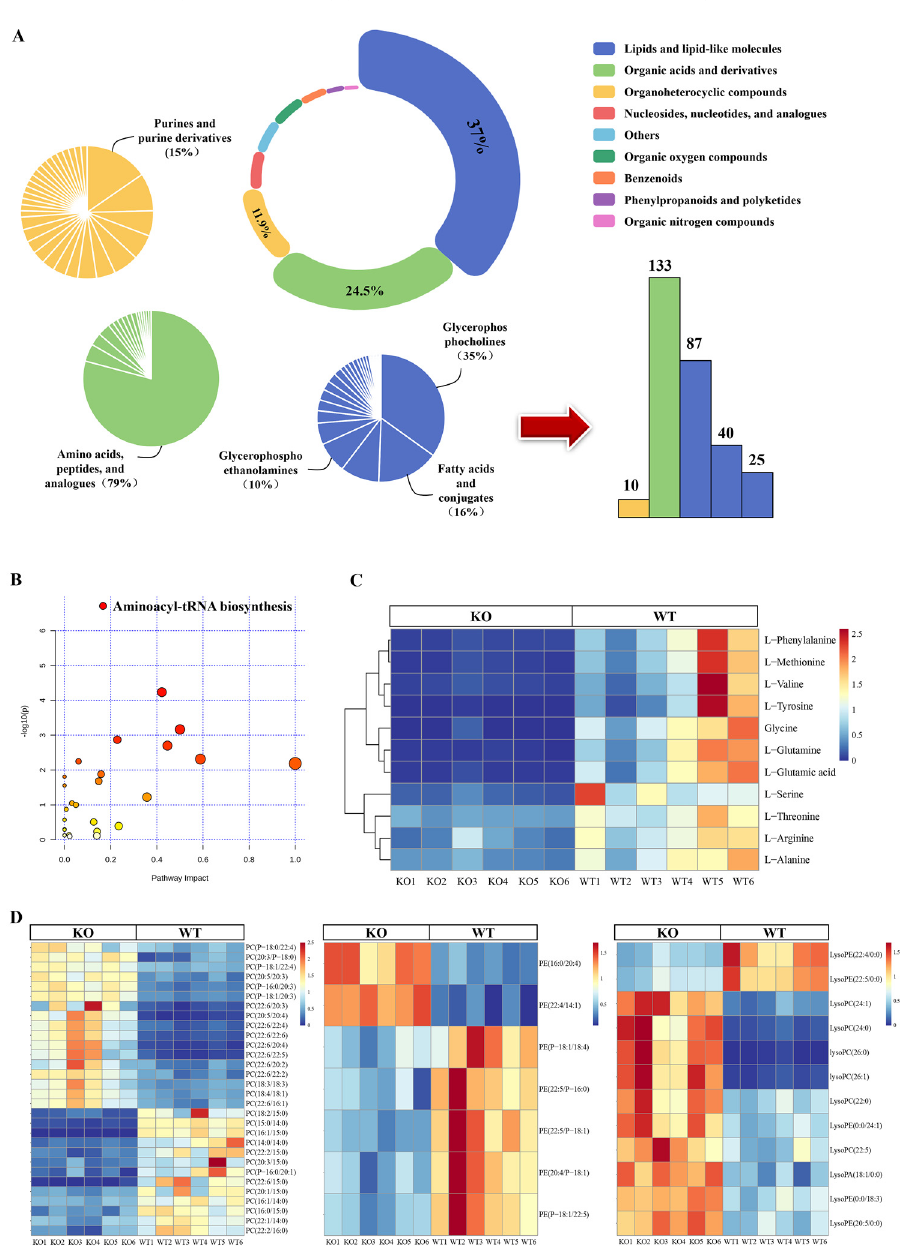
Figure 2. Identification of differential metabolites in KO cells. ( A ) Structural composition of differential metabolites. The composition and quantity distribution of the top three metabolites are displayed. ( B , C ) Functional annotation of amino acids, peptides, and analogues metabolites. Metabolite enrichment showed that aminoacyl-tRNA was the most severely affected, and all the detected metabolites were downregulated in the aminoacyl-tRNA pathway. ( D ) The altered glycerophospho- choline is mainly PE, LysoPE, LysoPC, and PC. Metabolites in this classification were both up- and downregulated in the cell, with upregulation predominating. On this heatmap, each box represents one substance, with red and blue representing up- and downregulation, respectively, and the darker the color, the greater the